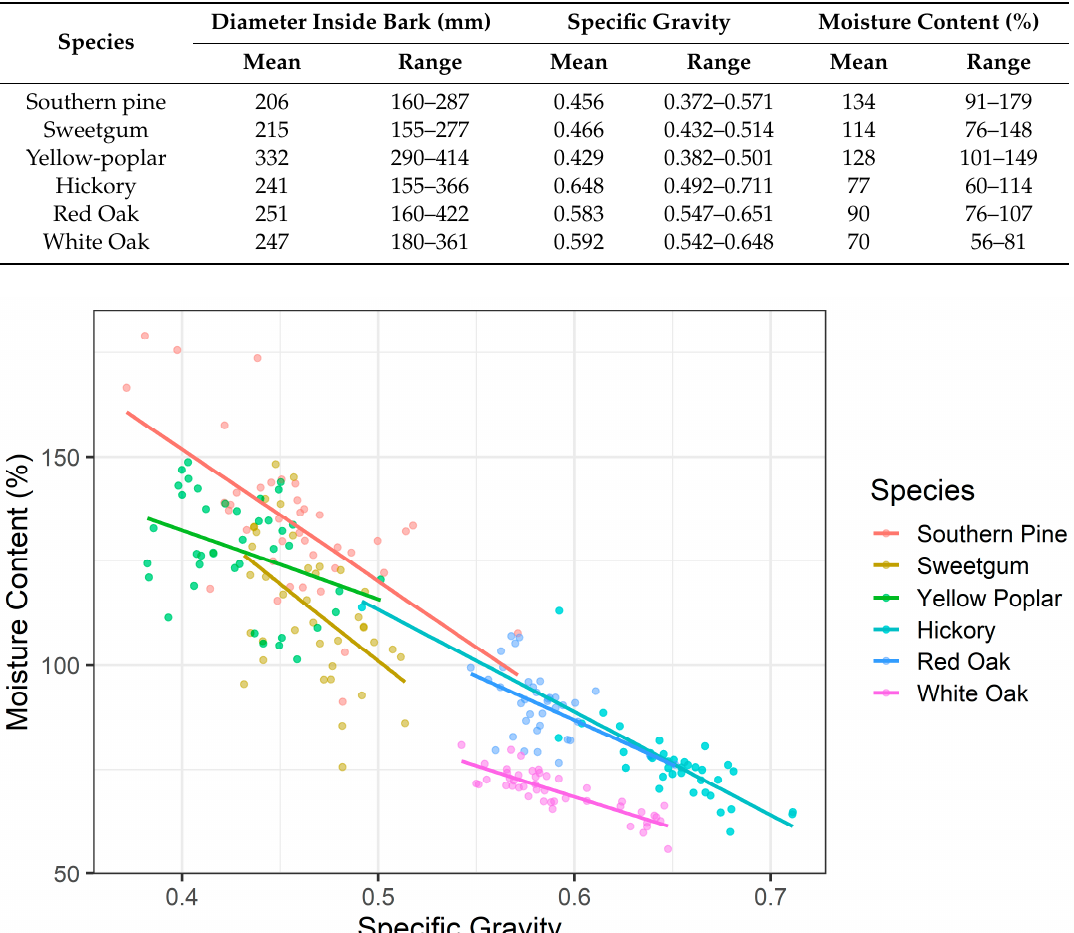
Table 1. Diameter, specific gravity, and initial moisture content for the calibration models.